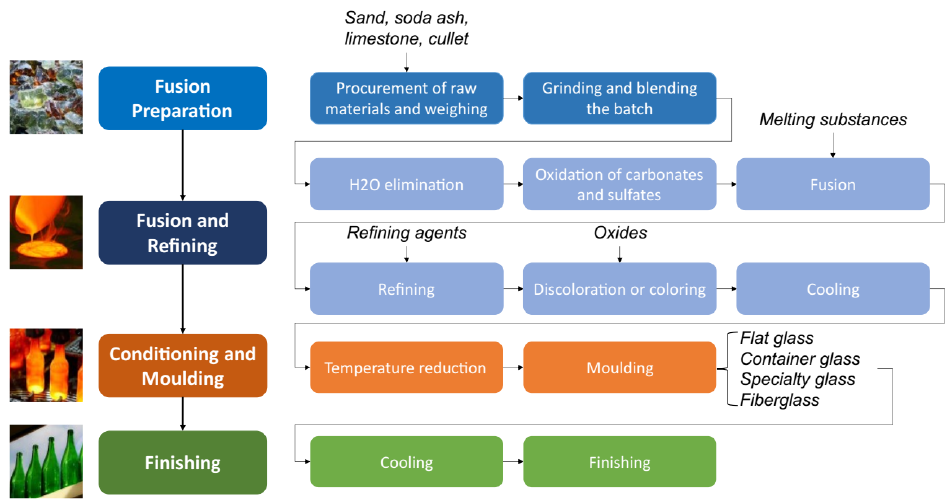
Figure 1. Representation of the main steps of the glass-production